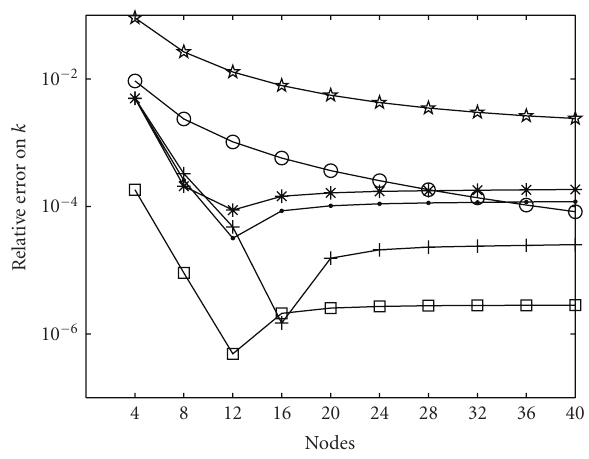
Figure 1: Convergence pattern for the calculation of the homoge- neous system. FD ( (cid:12) ); N ( (cid:2) ); BEM 0 10 24 ( ); BEM 1 10 24 ( ∗ ); BEM 1 10 240 ( • ); BEM 1 20 240